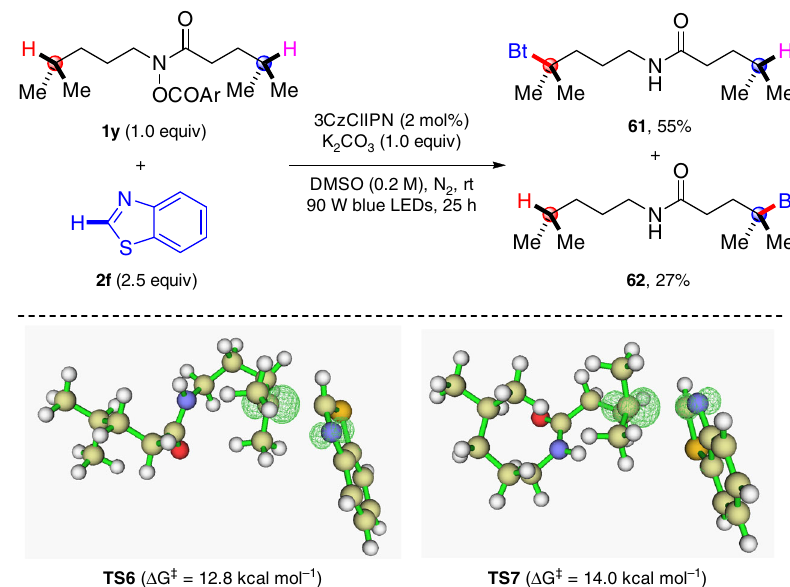
Fig. 6 Competition between different 1,5-HAT processes and subsequent C – C formation. Ar = p -CF 3 C 6 H